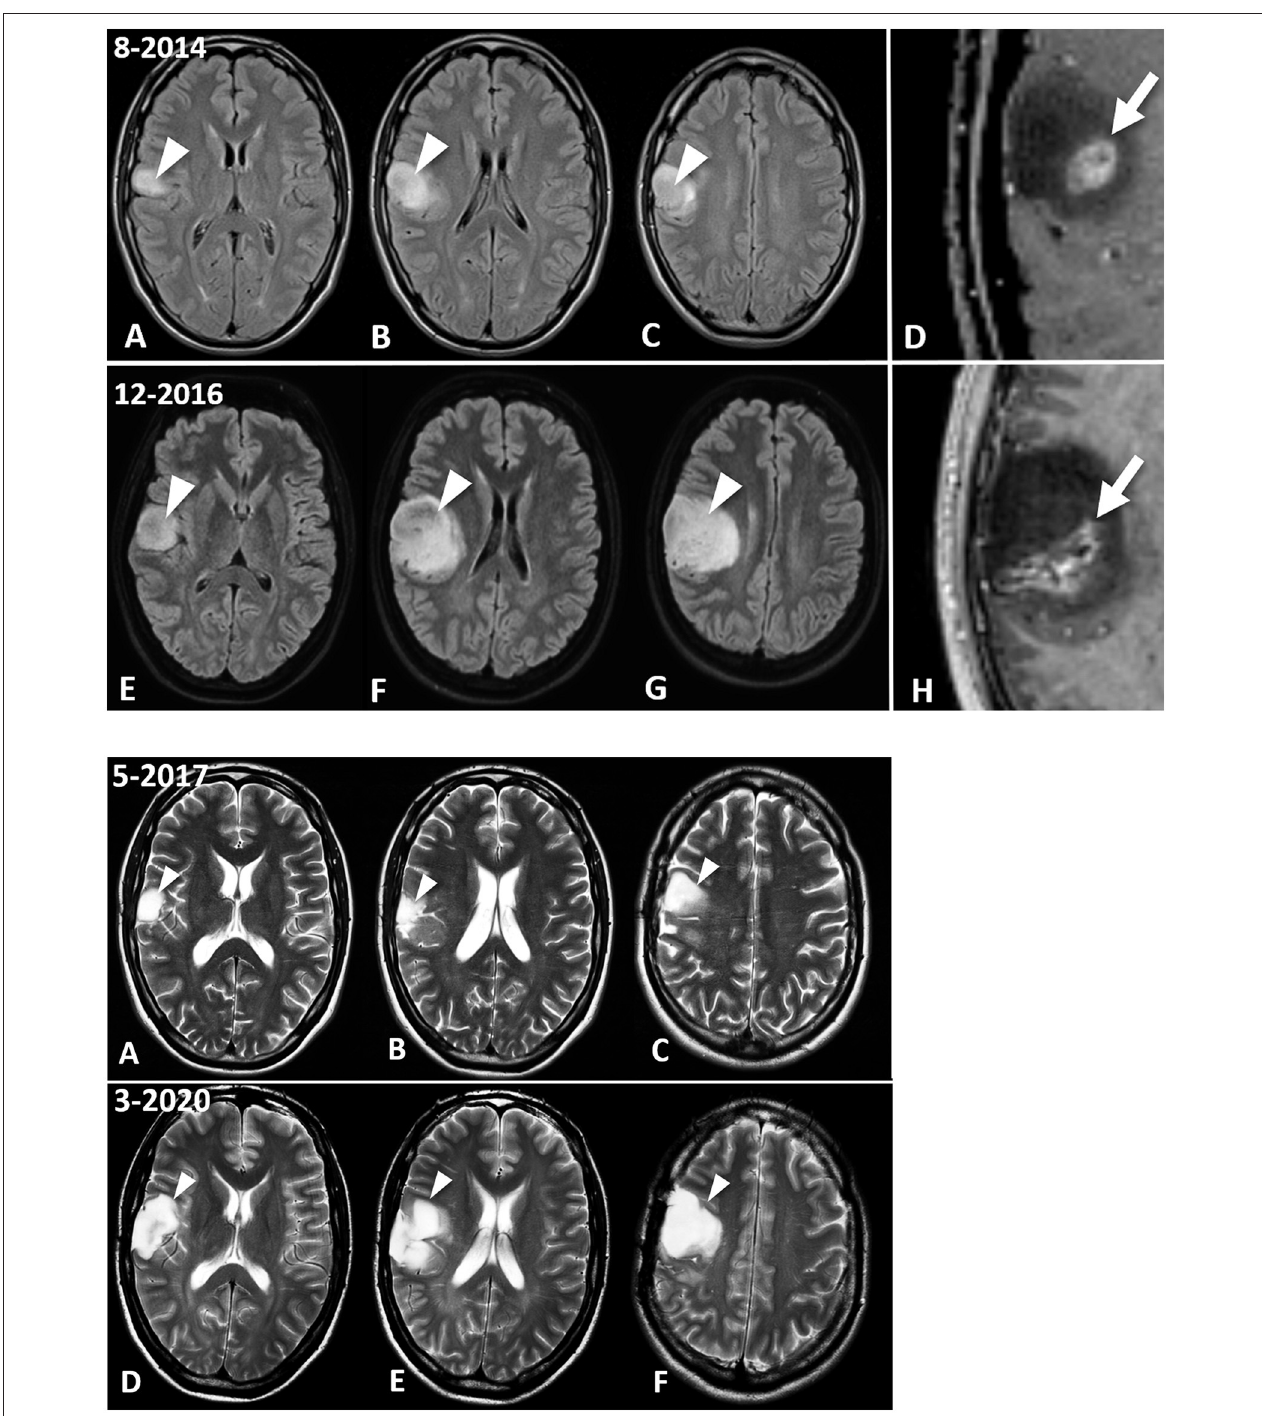
FIGURE 1 | MRI images of the patient’s brain tumour. Panel 1 . Fluid Attenuated Inversion Recovery (FLAIR) images show the IDH1 -mutant GBM at diagnosis in August 2014 (A–D) and ∼ 8 months later, at the last follow-up MRI examination (December 2016) prior to surgical excision of the enhancing nodule (E–H). The lesion discovered on August 2018 is centered in the right inferior frontal lobe (A,B, arrowheads), and abuts the premotor cortex (C, arrowhead). There is an enhancing nodule within the lesion, as seen in the magnified post-contrast image (D) (arrow). This enhancing lesion measured 1.25mL, which is calculated using the V = ABC/2 formula. Follow-up MRI (E–H) demonstrates interval progression of the non-enhancing tumor (arrowheads). Interval increase in size of the enhancing lesion, measuring 5.97mL, was also observed (H, arrow). Panel 2 shows the evolution of the lesion between the May 2017 surgical excision (A–C), and in the most recent MRI evaluation, dated March 2020 (D–F). T2-weighted images indicate the residual GBM (arrowheads). (B) shows the T2-hyperintense GBM filling the surgical cavity. The